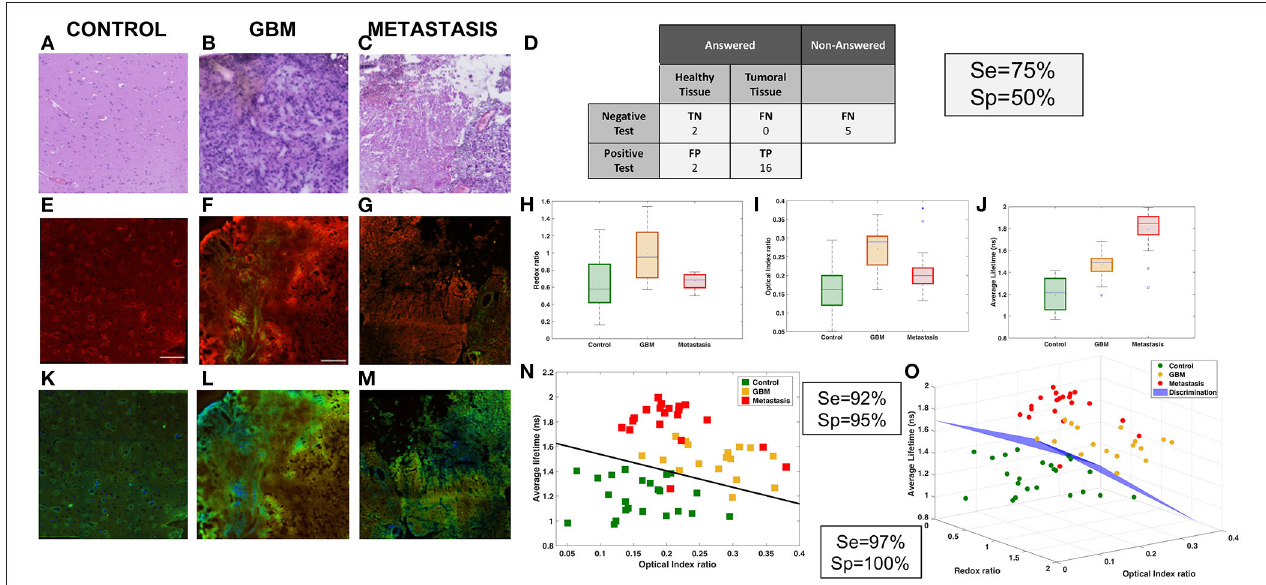
FIGURE 3 | Analysis of NIR data. Comparison of three tissue groups: control (A,E,K) , glioblastoma (B,F,L) and metastasis (C,G,M) with different imaging techniques H&E (A,B,C) , TPEF imaging (A,F,G) and FLIM (K,L,M) . Results of the “blind” analysis on TPEF for diagnosis (D) . Boxplot of the spectral molecular analysis, redox ratio (H) and optical index (I) , these results were combined in a scatter plot (N) . Boxplot of the average lifetime (J) . 3D-scatter of the two molecular indicators and the average lifetime to build a discriminative algorithm (O)